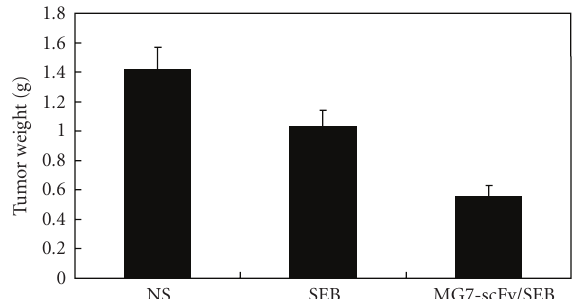
Figure 7: Ten gastric-cancer-bearing rats in each group were sub- cutaneously injected with same number tumor cells and observed for tumor nodules growth after being administrated with MG7- scFv/SEB, SEB, or NS. More potent inhibition of tumor growth was observed in MG7-scFv/SEB-treated group compared with the other two groups ( P < . 05).